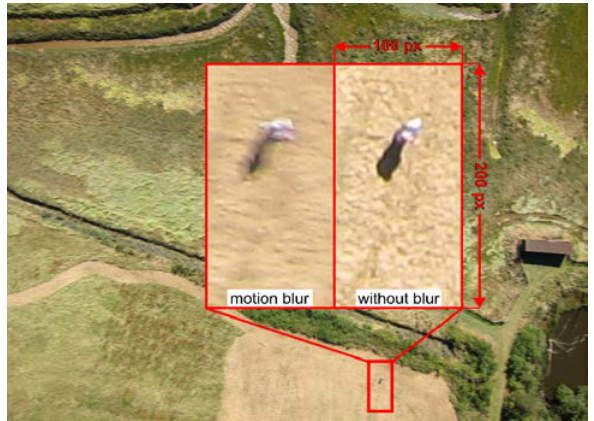
Figure 2. Motion blur example in high resolution UAV image. Image blur introduced by the forward motion of the UAV can